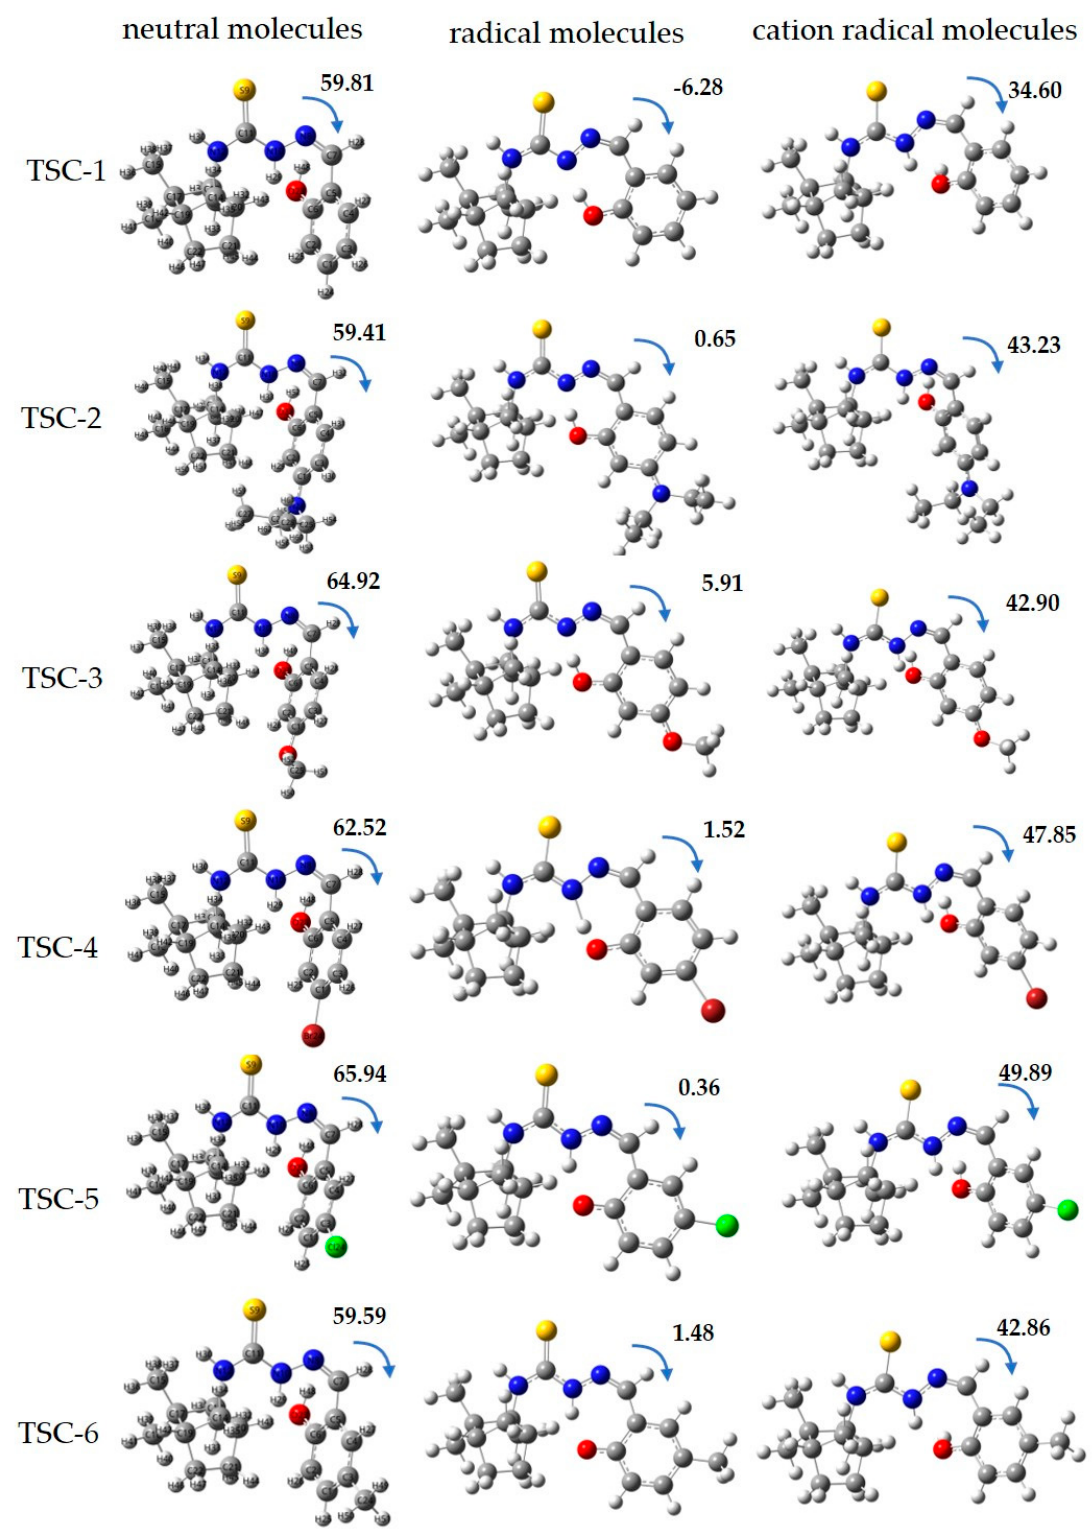
Figure 6. Geometric structure of the neutral molecules, radical molecules, cation radical molecules and atomic number of the studied camphene-based thiosemicarbazone. The blue, gray, yellow, white and red balls represent N atom, .C atom, S atom, H atom and O atom respectively